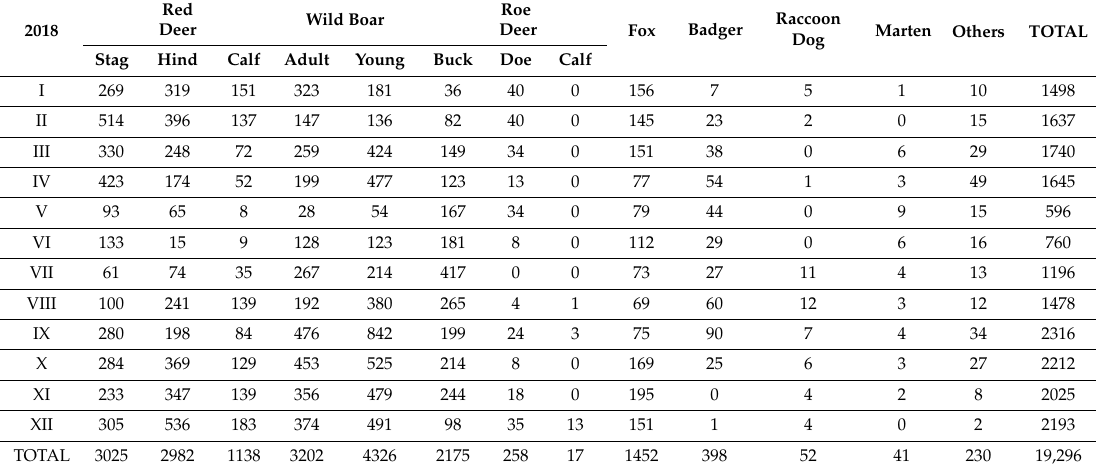
Table 2. Results of studies on wildlife migrations recorded using a monitoring set in 2018. 2018